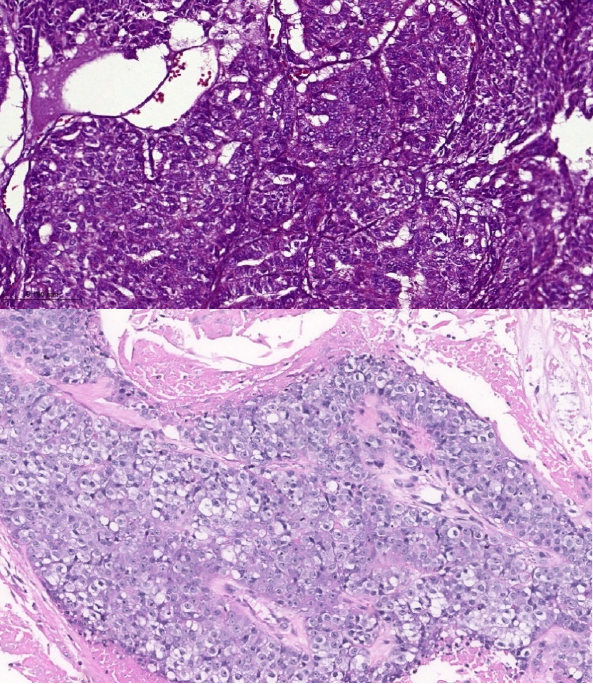
Figure 3. ( Top ) MAC of the minor salivary gland. ( Bottom ) MEC of the minor salivary gland.